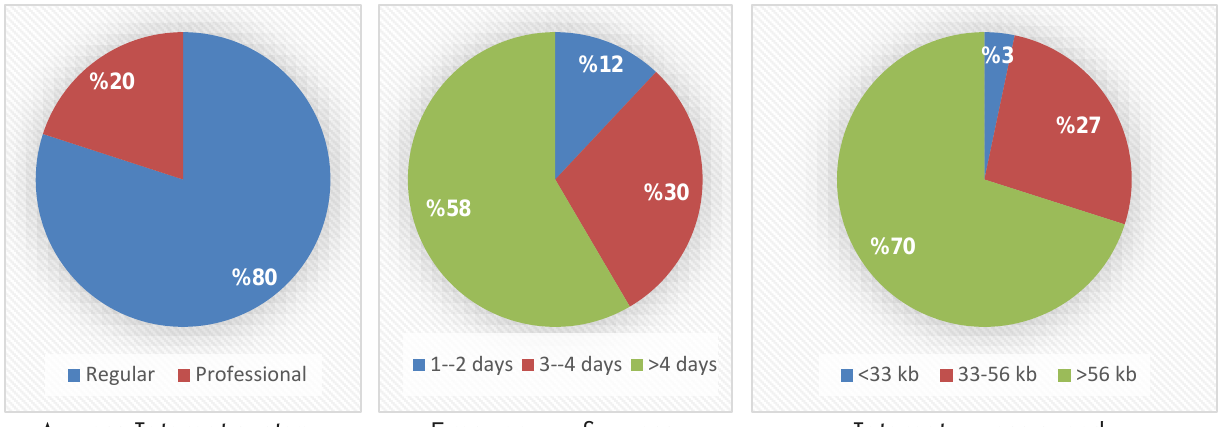
Fig. 2. Characteristics of the participants’ Internet usage